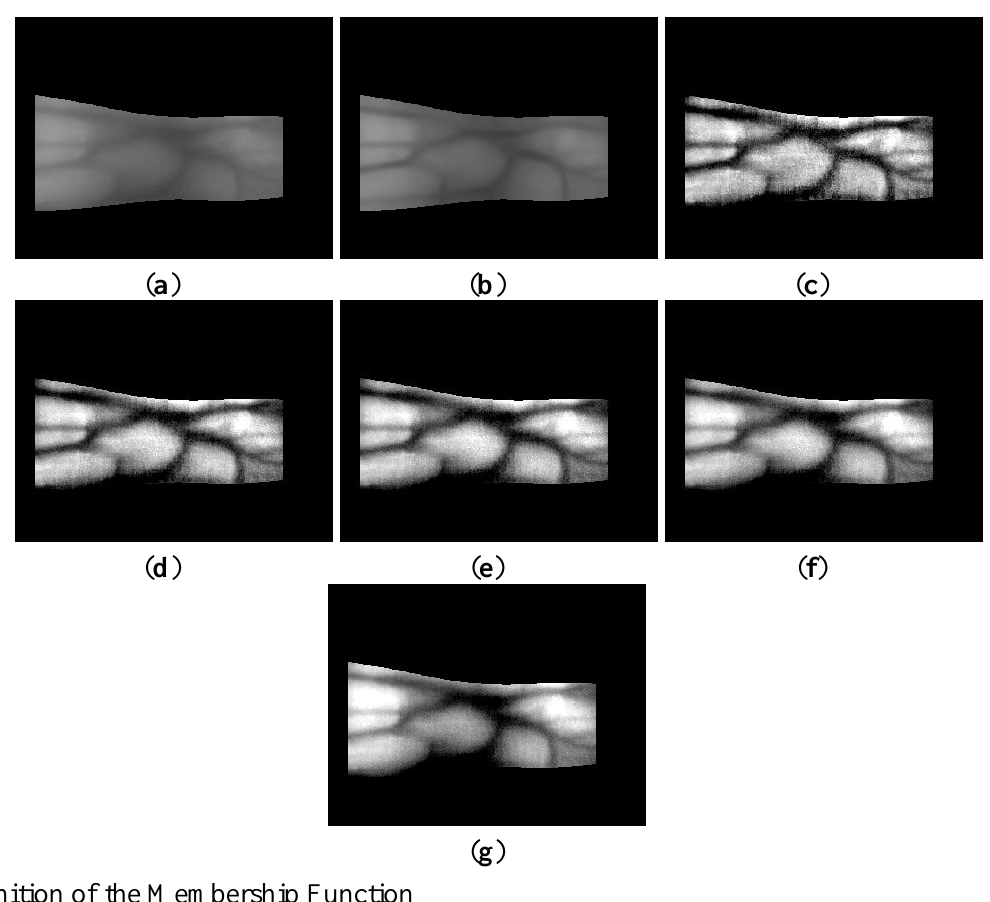
( g ) Figure 10. Comparison of the outputs with Gabor and Retinex filtering using images from database II: ( a ) original image of the detected finger boundaries; ( b ) results with Gabor filtering; and results with Retinex filtering using sigma values of ( c ) 10, ( d ) 15, ( e ) 20, ( f ) 25, and ( g )